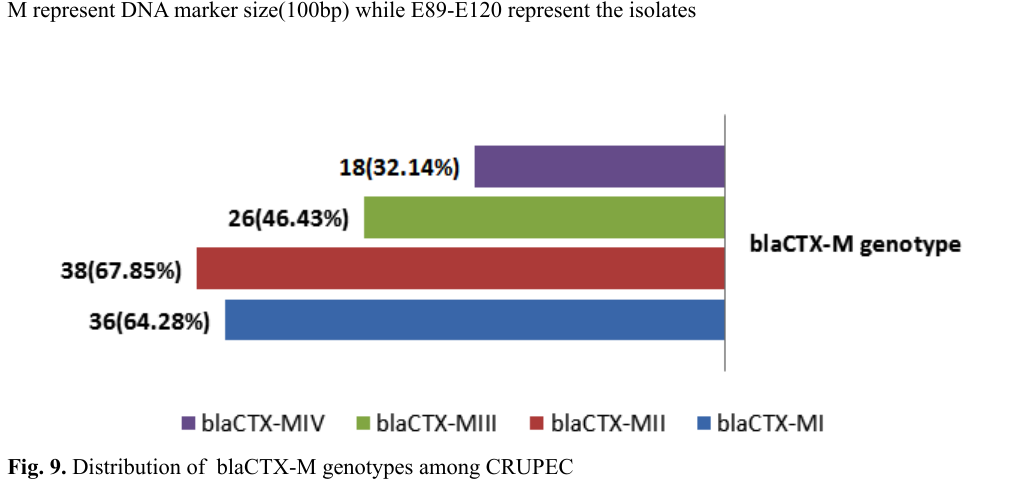
Fig. 9. Distribution of blaCTX-M genotypes among